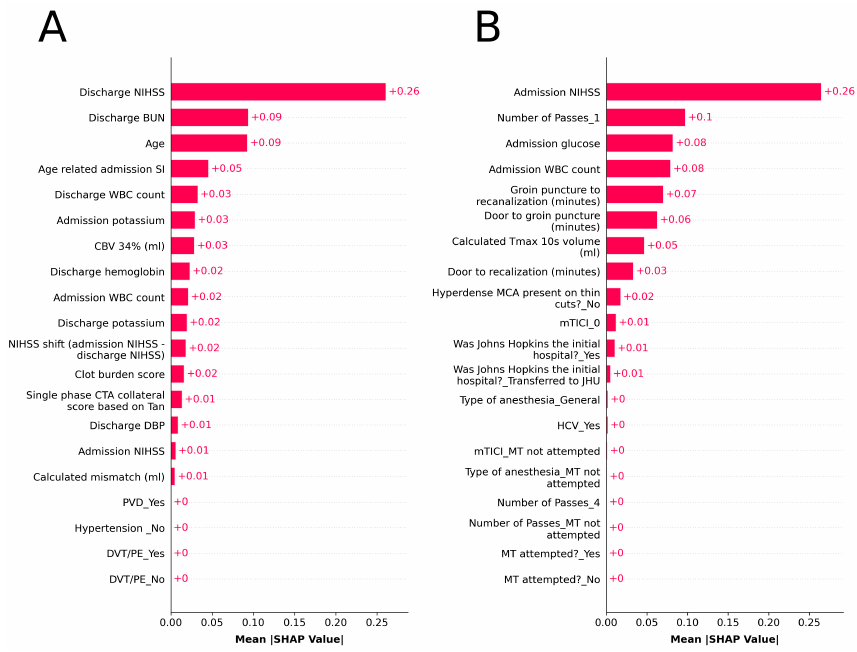
Figure 3. Sorted feature importance and their mean SHAP values ( A ) for the model predicting the mRS at 90 days with the LightGBM algorithm, ( B ) for the model predicting the NIHSS shift with the Random Forest algorithm.